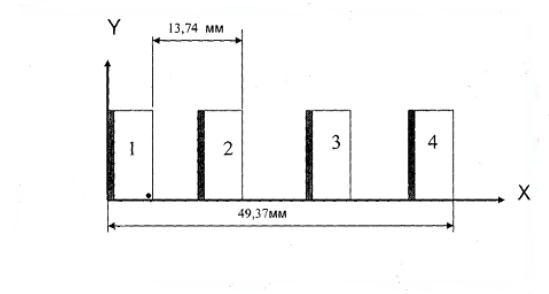
Figure 3. MSS micromatrix placement in focal plane.